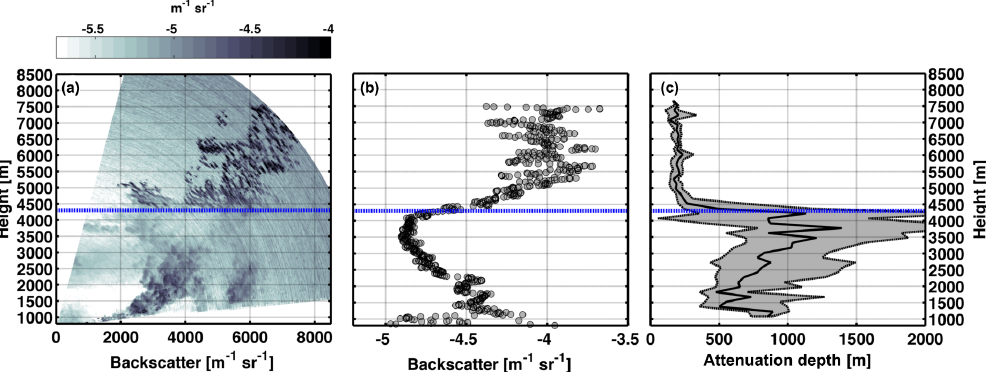
Figure 15. Statistical analysis of lidar data between 15:45 and 20:08PDT on 30 July 2015. (a) Maximum backscatter as a function of height and distance. (b) Maximum backscatter as a function of height only. (c) 5, 50, and 95th percentiles of the attenuation depth as a function of height. The dashed blue line indicates the inferred condensation level.